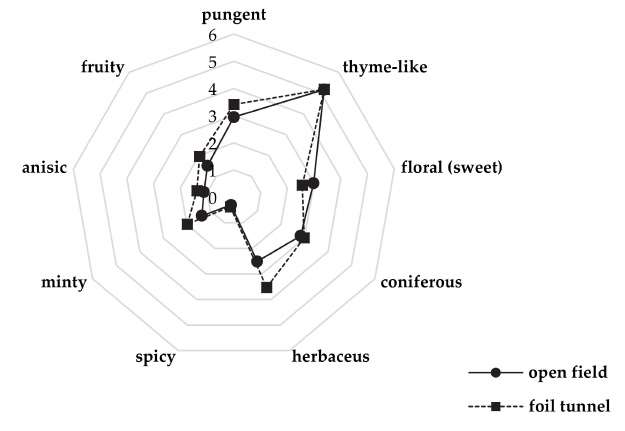
Figure 5. Sensory profile of common thyme herb